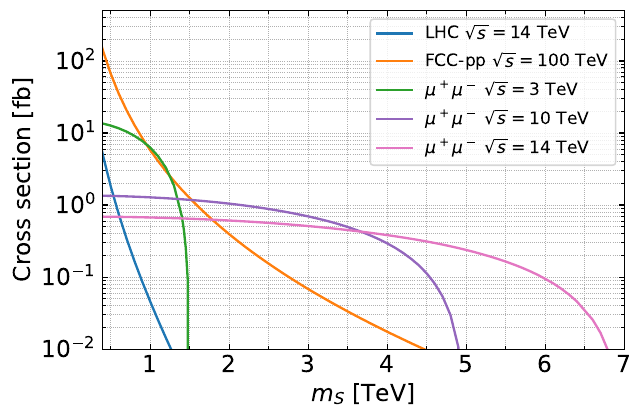
pair production at the 14 TeV HL-LHC and some of η −− 5 5